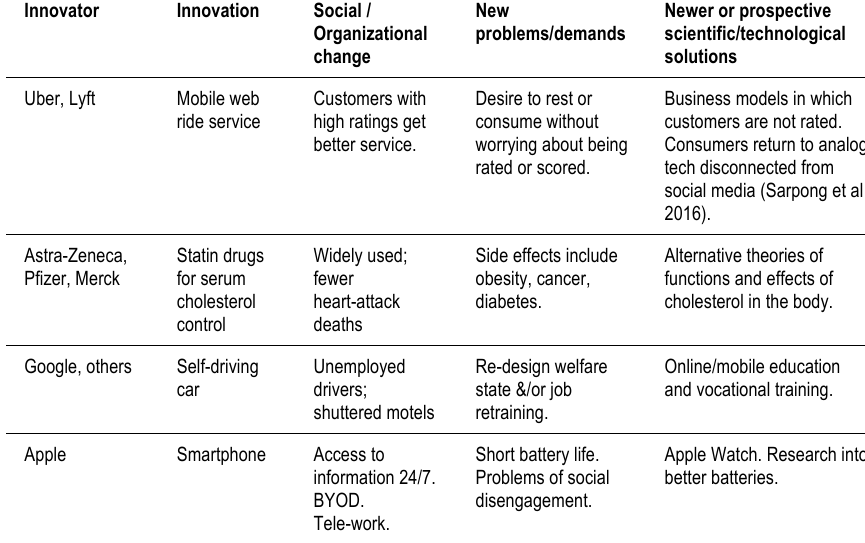
Table 2. Circle of Innovation, short